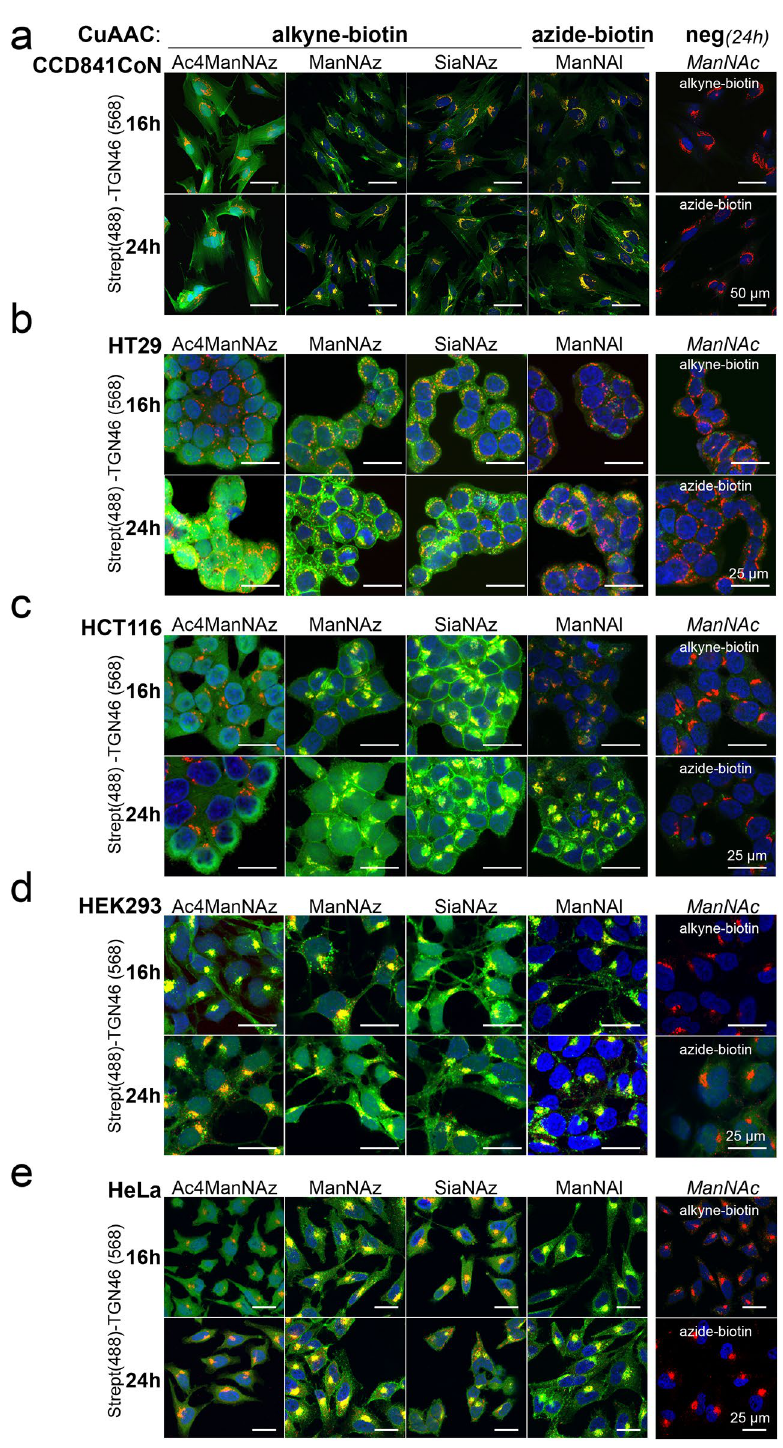
Figure 3. Confocal microscopy detection of labeled sialoglycoconjugates. Cells were incubated 16 h or 24 h with either the indicated analog or ManNAc (negative control). Then they were fixed and permeabilized before CuAAC with the appropriate biotin probe, followed by overnight incubation with anti-TGN46 (Golgi marker). Biotinylated proteins and TGN46 were revealed with Streptavidin-DyLight488 and AF568-conjugated secondary antibody, respectively. Nuclei were stained with DAPI before mounting. Two experiments were